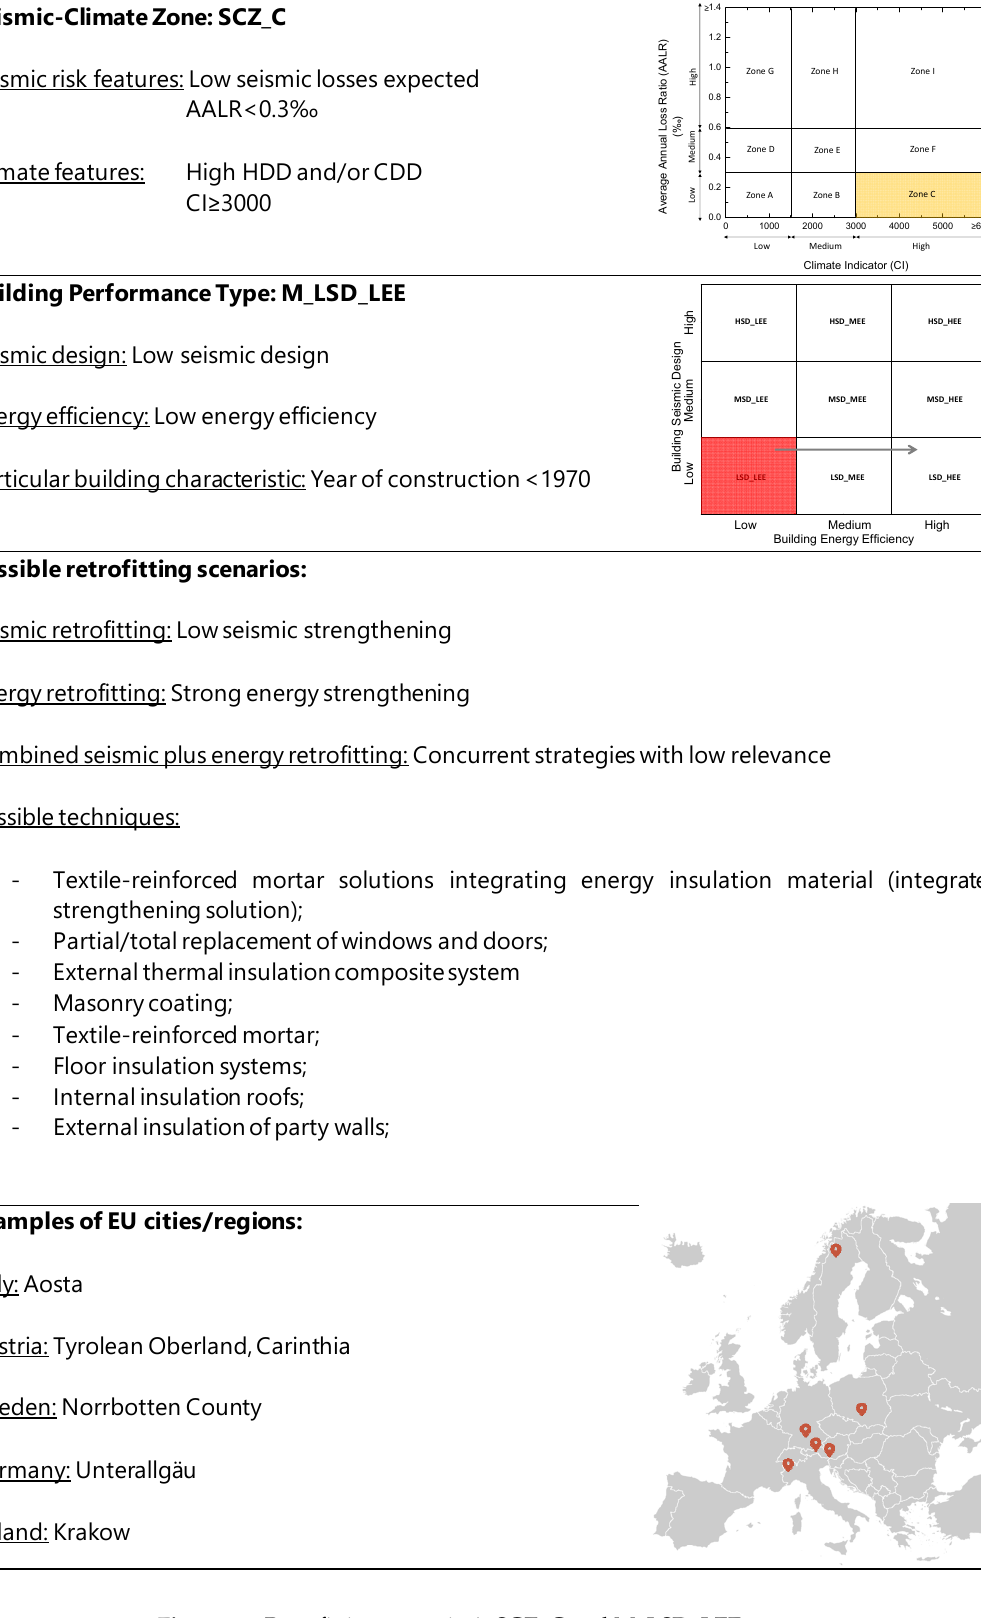
Figure 11. Retrofitting scenario 1: SCZ_C and M_LSD_LEE.